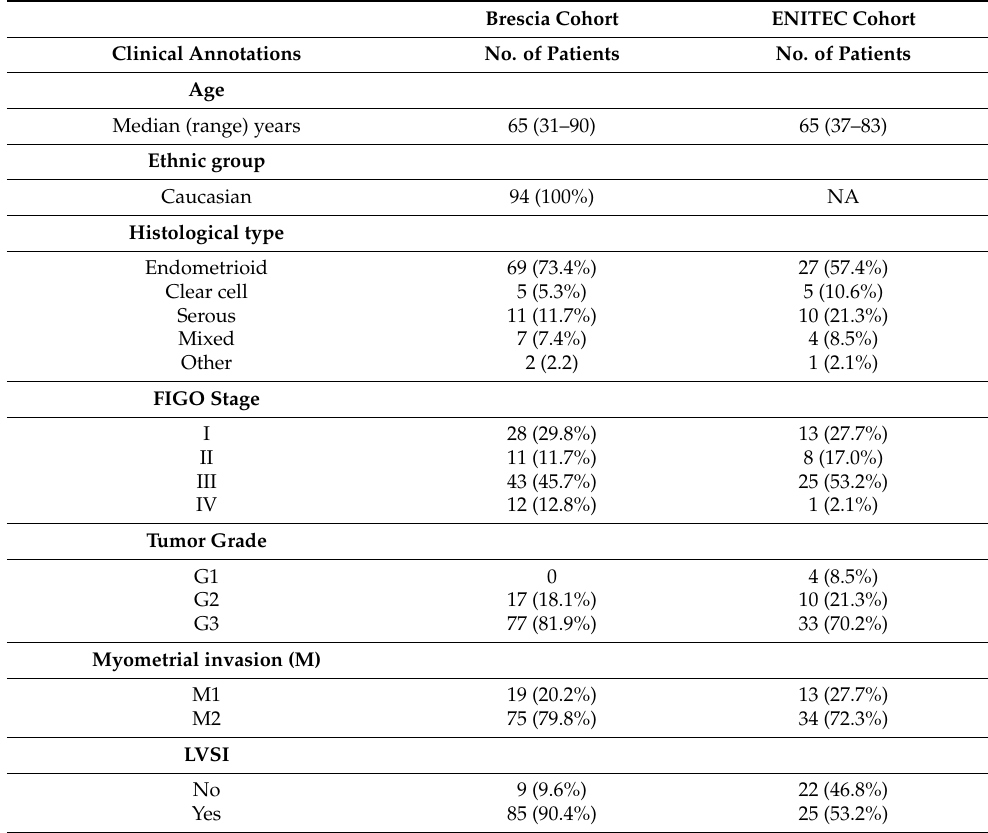
Table A1. Clinicopathological characteristics of EC